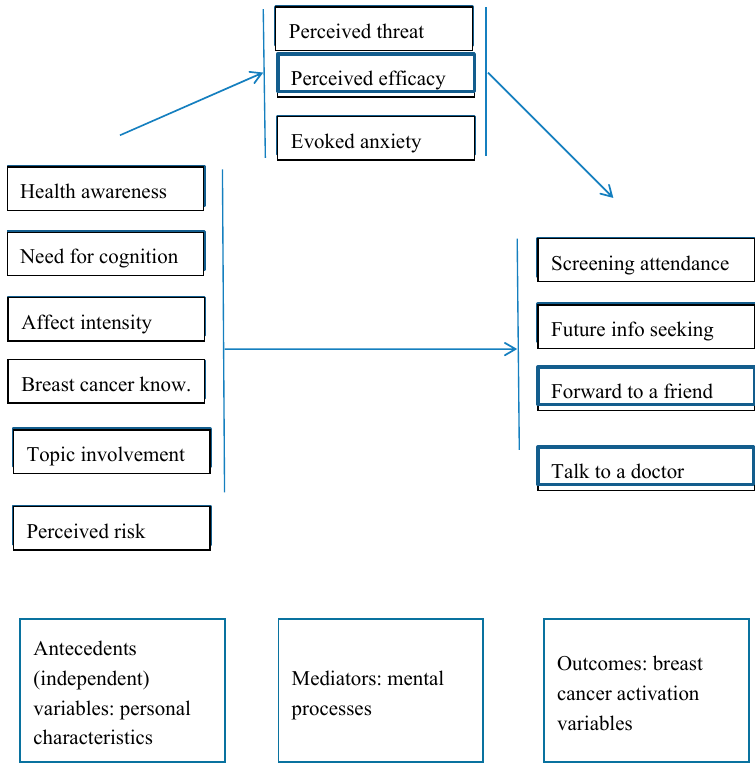
Figure 1. Conceptual framework.